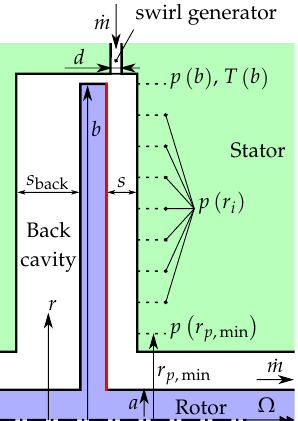
Figure 1. A schematic of the large rotor–stator cavity test rig. The dashed lines indicate the pressure measurements; measured torque coefficients c M correspond to the torque acting on the surface indicated by the red